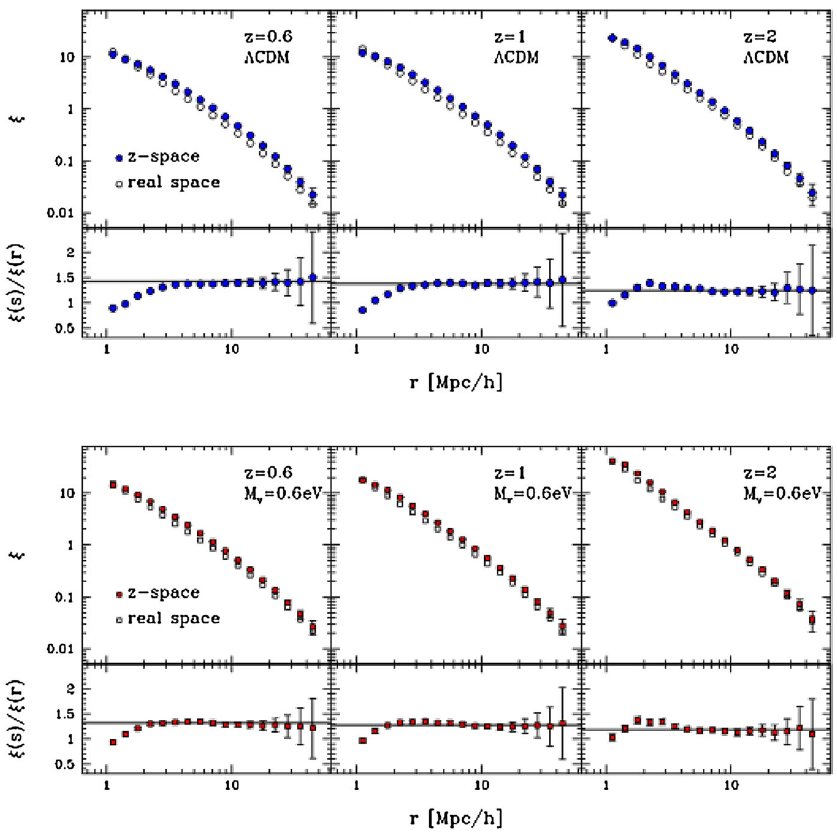
Fig. 47 Two-point auto-correlation function in real and redshift space of the DM haloes in the Λ CDM N -body simulation (blue circles) and in the simulation with Σ = 0 . 6 eV (red squares). The bottom panels show the ratio between them, compared with the theoretical